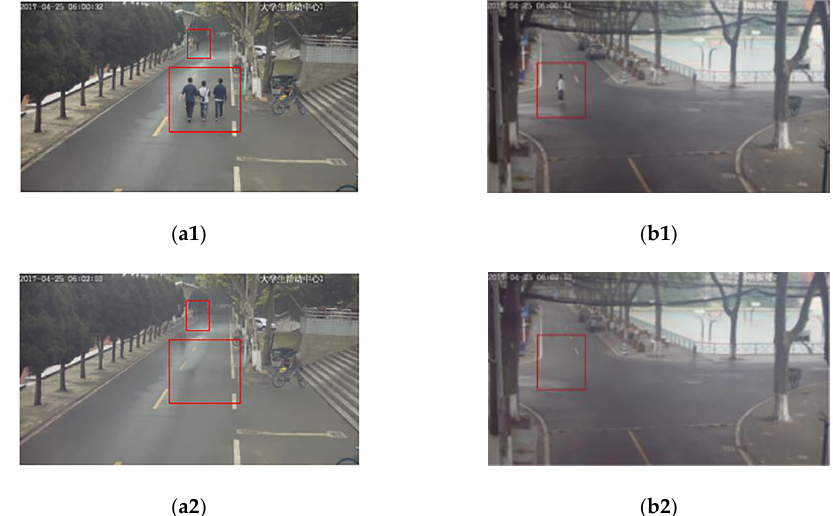
Figure 8. The results of background images extraction: Original Images ( a1 , b1 ) and Background Images ( a2 , b2